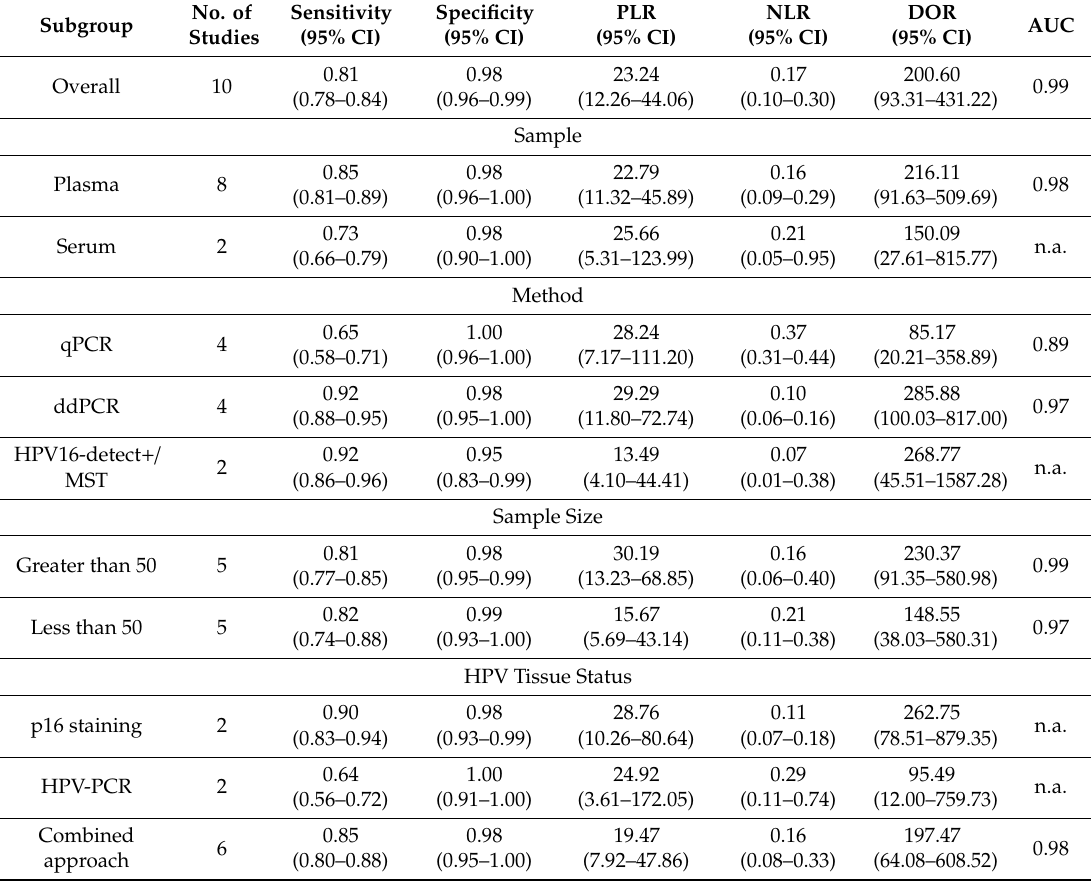
Table 2. Results of the subgroup